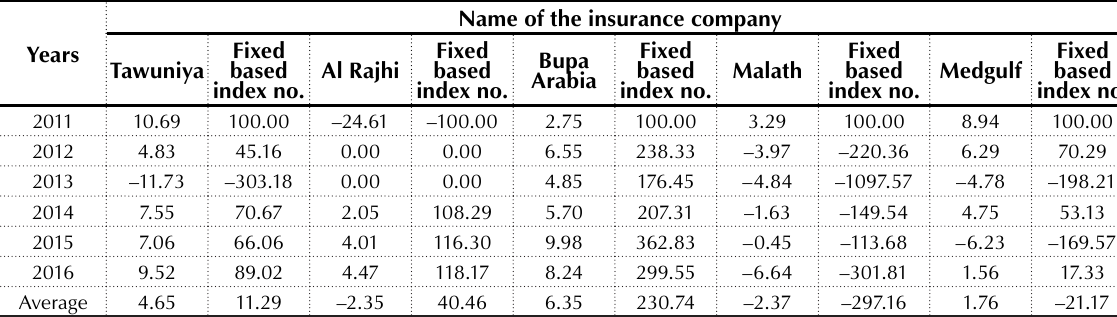
Table 2. Sales profitability ratio (ratios are in percentage)